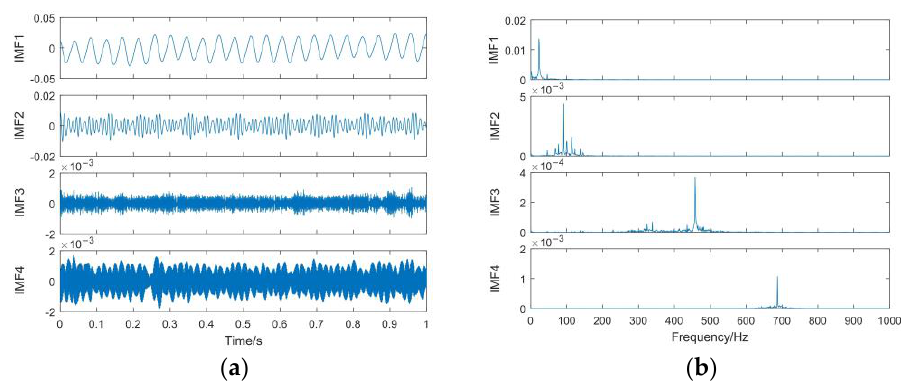
Figure 10. VMD results of IF signal: ( a ) IMF components, ( b ) frequency spectrum of IMF compo- nents.